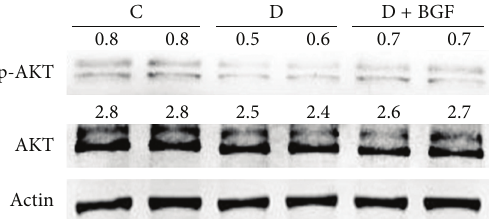
Figure 6: The activity of PIP3/AKT signal pathway was unchanged after BGF treatment. The phosphorylated and total AKT levels were evaluated by Western blot